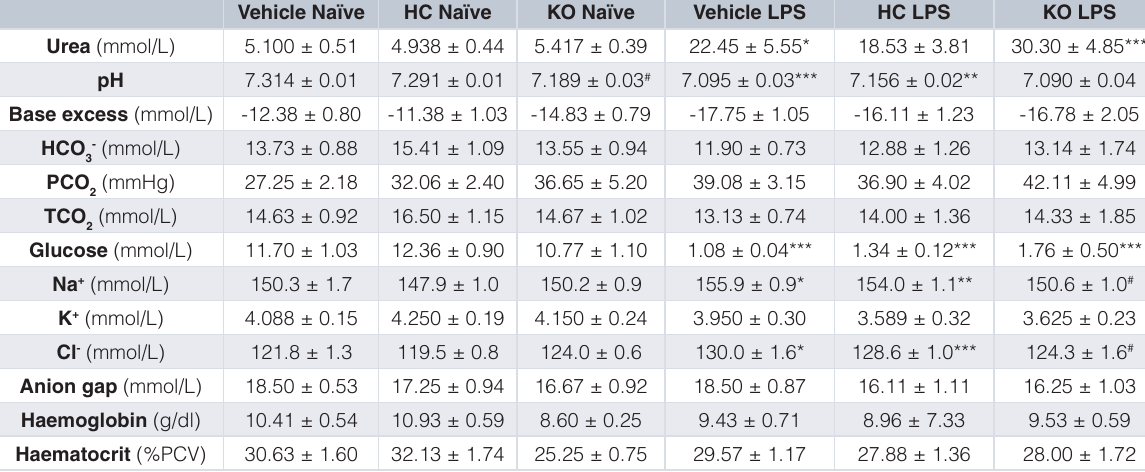
Table 2. Blood biochemistry in healthy and endotoxaemic TRPV4 WT and KO mice. Blood gas and biochemistry were measured from venous blood samples by iSTAT point-of-care analyser in either TRPV4 KO mice, or WT mice treated i.p. with vehicle (10% DMSO) or HC-067047 (HC) for 24 h, either under naïve or endotoxaemic (LPS 12.5 mg/kg, i.v., 24 h) conditions. Data are presented as mean ± SEM. *p<0.05, **p<0.01, ***p<0.001, relative to naïve controls; # p<0.05, relative to vehicle-treated controls, 1-way ANOVA + Bonferroni post-hoc test (n =